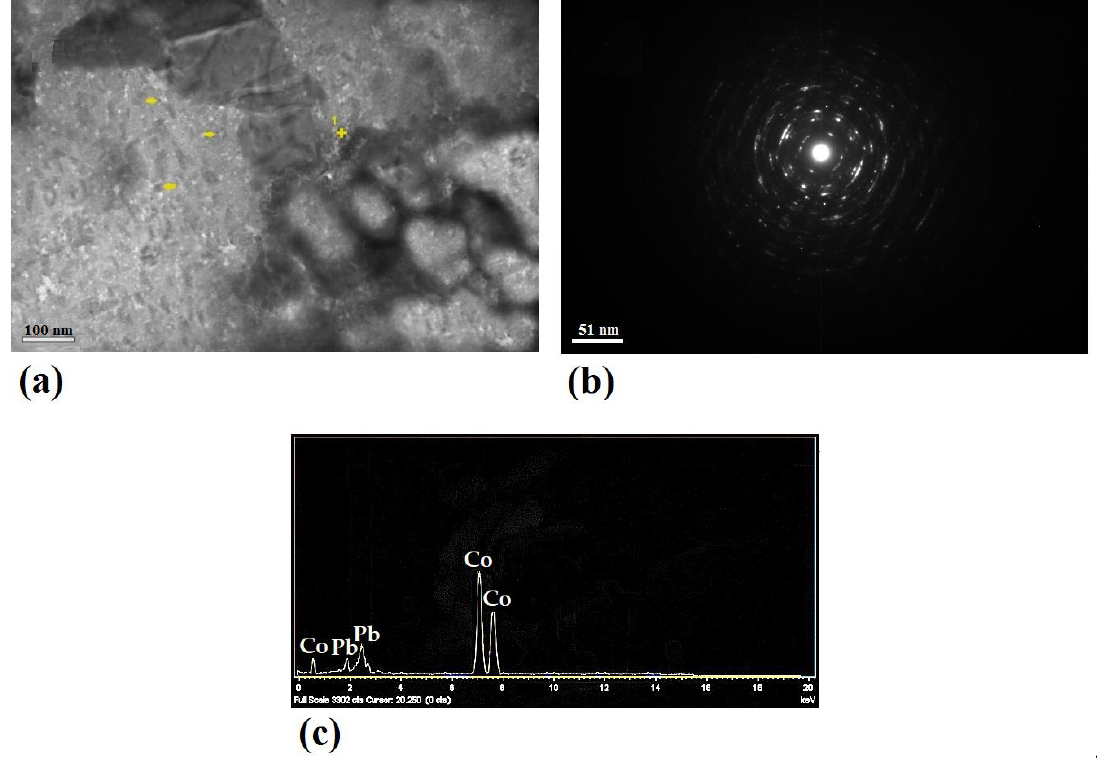
Figure 6. ( a ) Bright field image, ( b ) SAD pattern, and ( c ) EDS result of Pb – 0.5%Co – 10pass. As a result, secondary phase particles could inhibit grains ’ growth, leading to a strongly pinned microstructure. Pinning of grain boundary was enhanced by increasing the volume fraction of secondary phase particles. The lower density of cobalt (8.9 g/cm 3 )